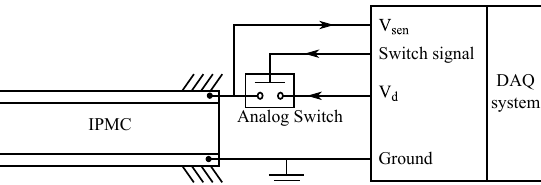
Figure 19. Implementation of switching between IPMC actuation and sensing for SSA [144]. Instantaneous open state is periodically introduced to the actuation voltage to measure charge stored on IPMC due to actuation voltage